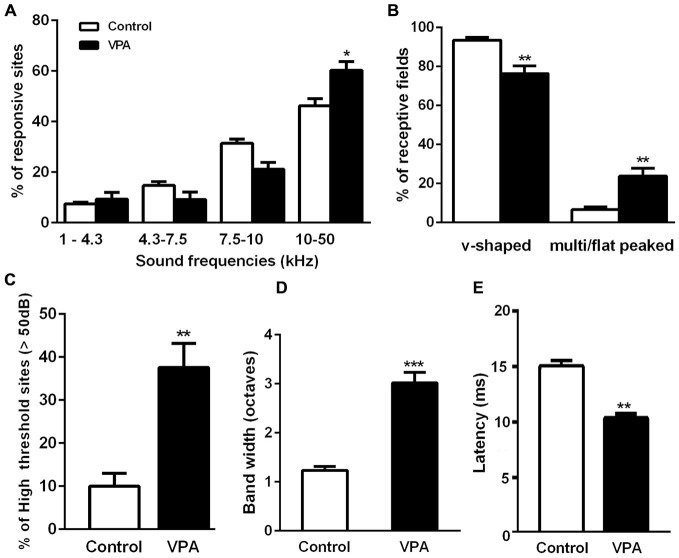
Embryonic administration of VPA alters the maturation of receptive fields in AI. (A) Fraction of AI responsive sites at distinct sound frequency bands. VPA rats present larger cortical representation for sound frequencies above 10 kHz (F(3, 30) = 63.37, p < 0.05; two-way ANOVA with repeated measures, Bonferroni’s multiple comparison test). (B) Relative number of single and multi/flat-peaked receptive fields in each group. V-shaped receptive fields are significantly reduced in VPA animals as compared to controls, whereas multi-peaked sites are increased in this group (p < 0.01, Student’s t-test). (C) Sound intensity threshold of AI neurons in VPA rats is significantly higher than those measured in control animals (p < 0.01, Student’s t-test). (D) Frequency response bandwidth 10 dB above sound intensity threshold (BW10). Note that BW10 is significantly augmented in VPA rats (p < 0.0001, Student’s t-test). (E) Latency of neuronal responses in AI was significantly decreased in VPA rats as compared to controls (p < 0.01, Student’s t-test). Values are means ± SEM. *p < 0.05; **p < 0.01; ***p < 0.0001.